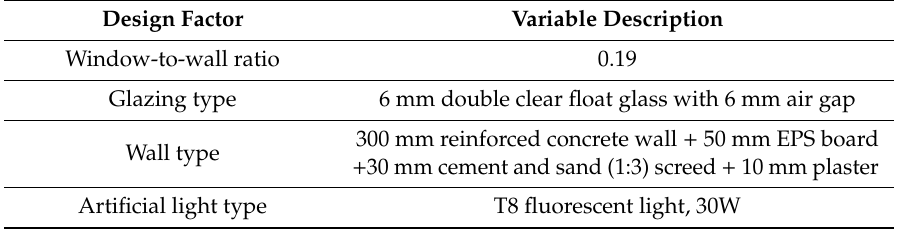
Figure 2. Outline of the lecture room. Table 1. Initial design of the case.